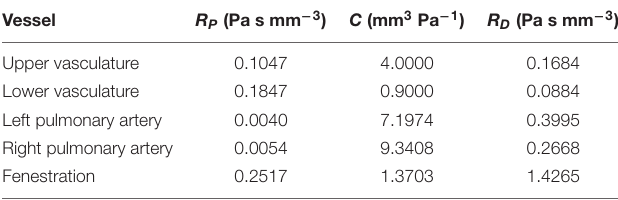
TABLE 2 | Calibrated parameter values of Windkessel models.